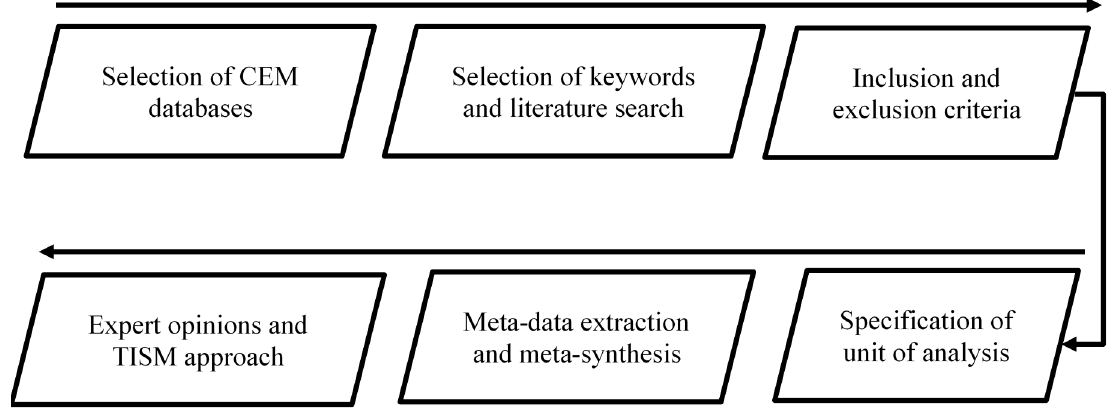
Figure 1. A methodological framework for the study.